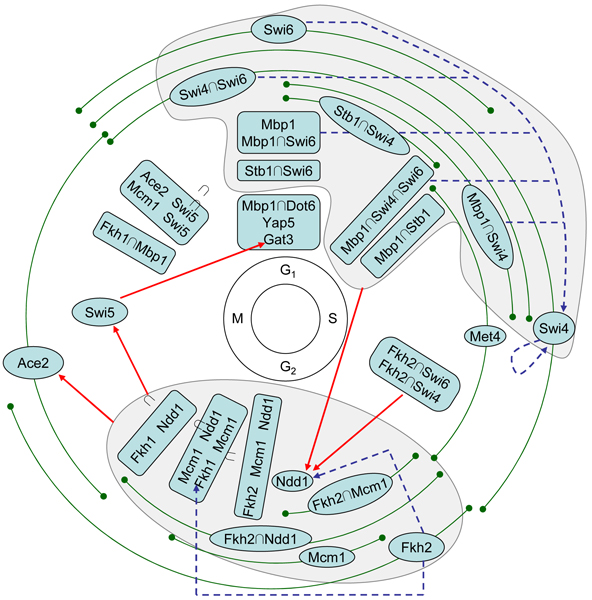
A model for the yeast cell cycle transcriptional regulatory network learned by our method. The text inside each dark node (ellipse or rounded rectangle) represents one or more regulatory rules. The position of a node, together with the green arc crossing it if there is one, represents the period during which the rules inside are functioning. The gray area on the top contains a module of rules that regulate late G1/S phase, and the one on the bottom encloses a module of rules that regulate G2/M phase. A solid red line represents that a set of regulatory rules regulates a TF outside the module, while a dashed blue line represents that a set of regulatory rules regulates a TF within the same module.